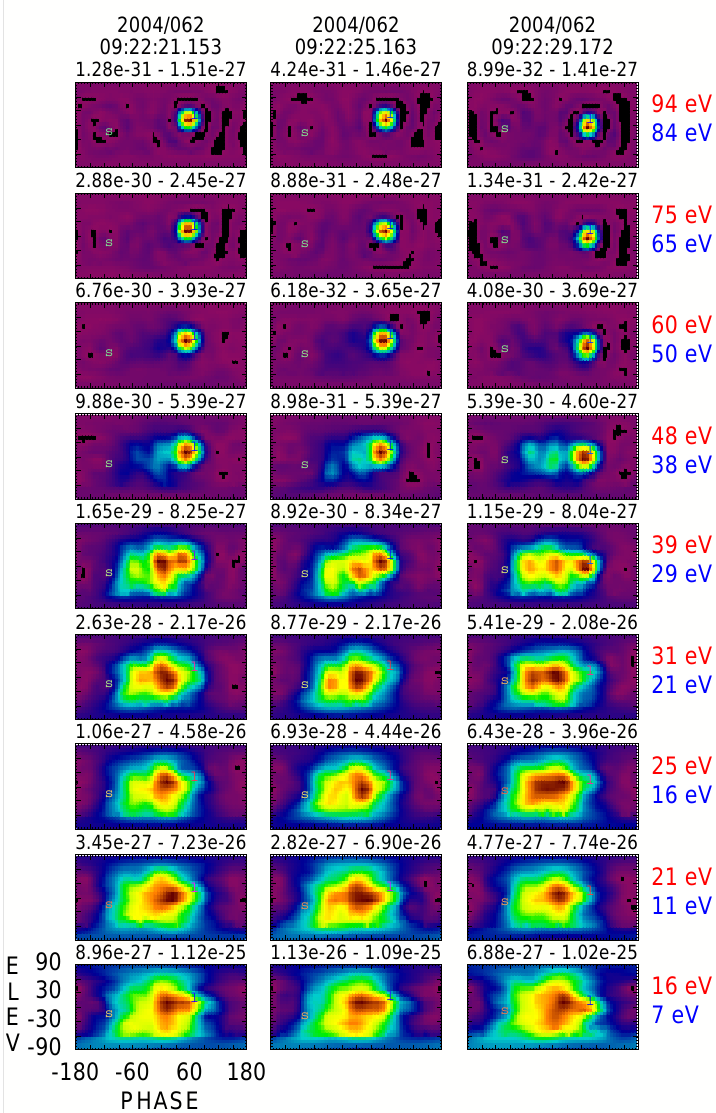
Fig. 4. PT plots from a set of three successive eVDFs with a more horizontal magnetic field orientation. The proto-halo is less dominant in these plots and the halo appears at a higher in energy than in Fig.